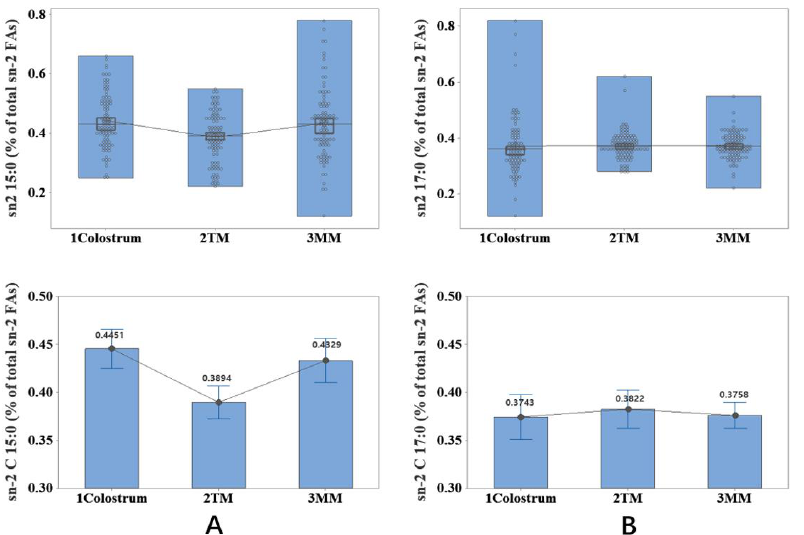
Figure 2. Association between lactation stage and the odd-chain fatty acids at sn-2 position (( A ): C15:0, ( B ): C17:0) in human milk. Undecylic acid = C11:0; Tridecylic acid = C13:0; Pentadecylic acid = C15:0; Margaric acid = C17:0; TM = Transitional milk; MM = Mature milk.